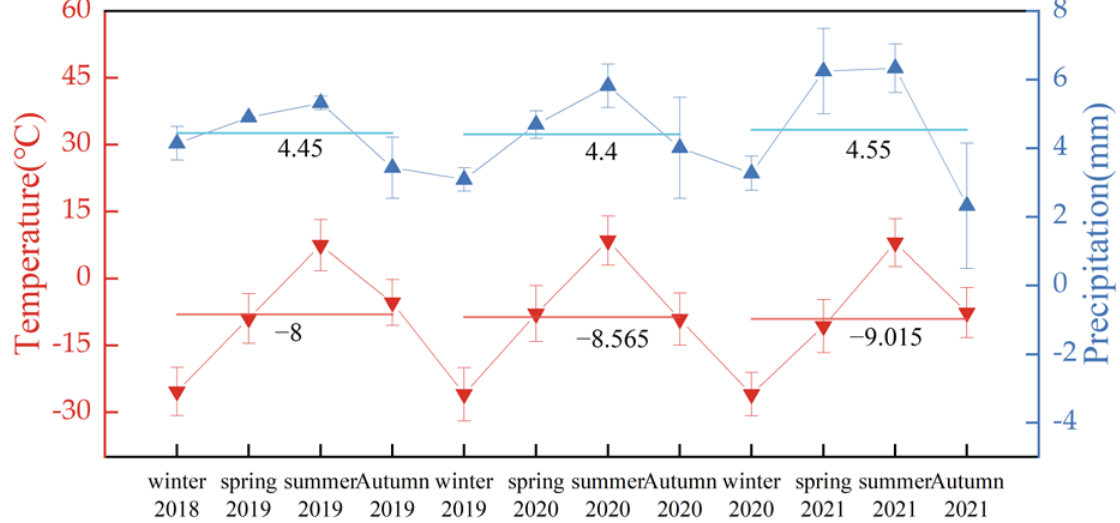
Figure 10. Seasonal variations in temperature and precipitation in the